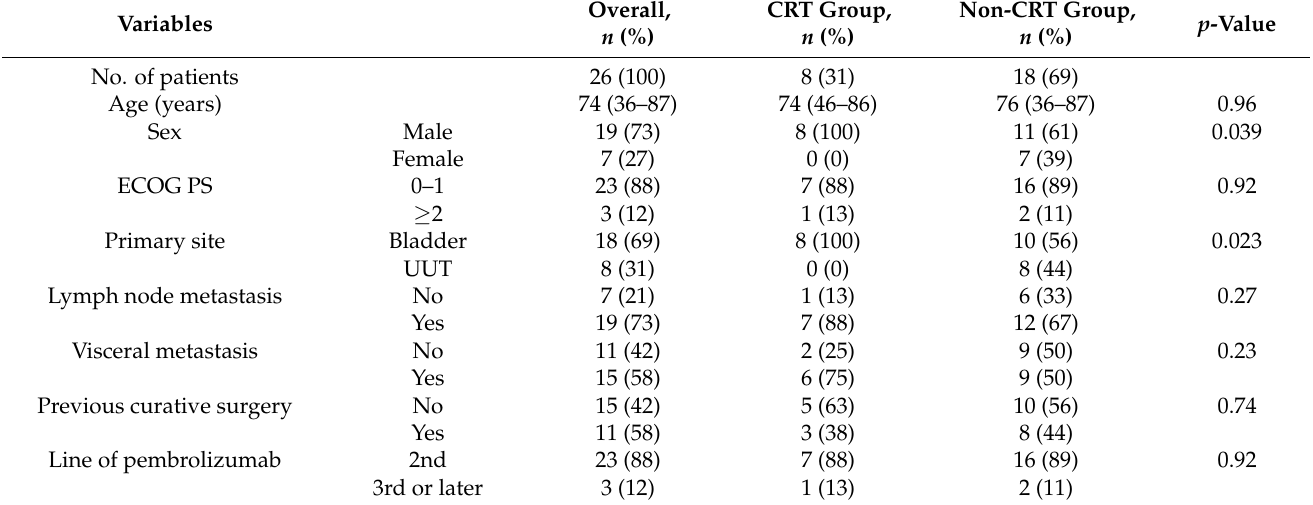
Figure 1. Associations of cisplatin-based CRT with therapeutic response and survival after pem- brolizumab therapy in patients with advanced urothelial carcinoma (UC). ( A ) Objective response rate (ORR), ( B ) progression-free survival (PFS), and ( C ) overall survival (OS) are compared between CRT ( n = 8) and Non-CRT ( n = 18) groups. ( D ) Comparison of OS curves between CRT ( n = 8) and Non-CRT ( n = 10) groups in 18 bladder cancer patients. The p -value is calculated by the chi-square test for ORR and the log-rank test for PFS and OS. Asterisks indicate p -values comparing two groups, as indicated in the figure. NS, not significant; * p < 0.05. Table 1. Patient characteristics.